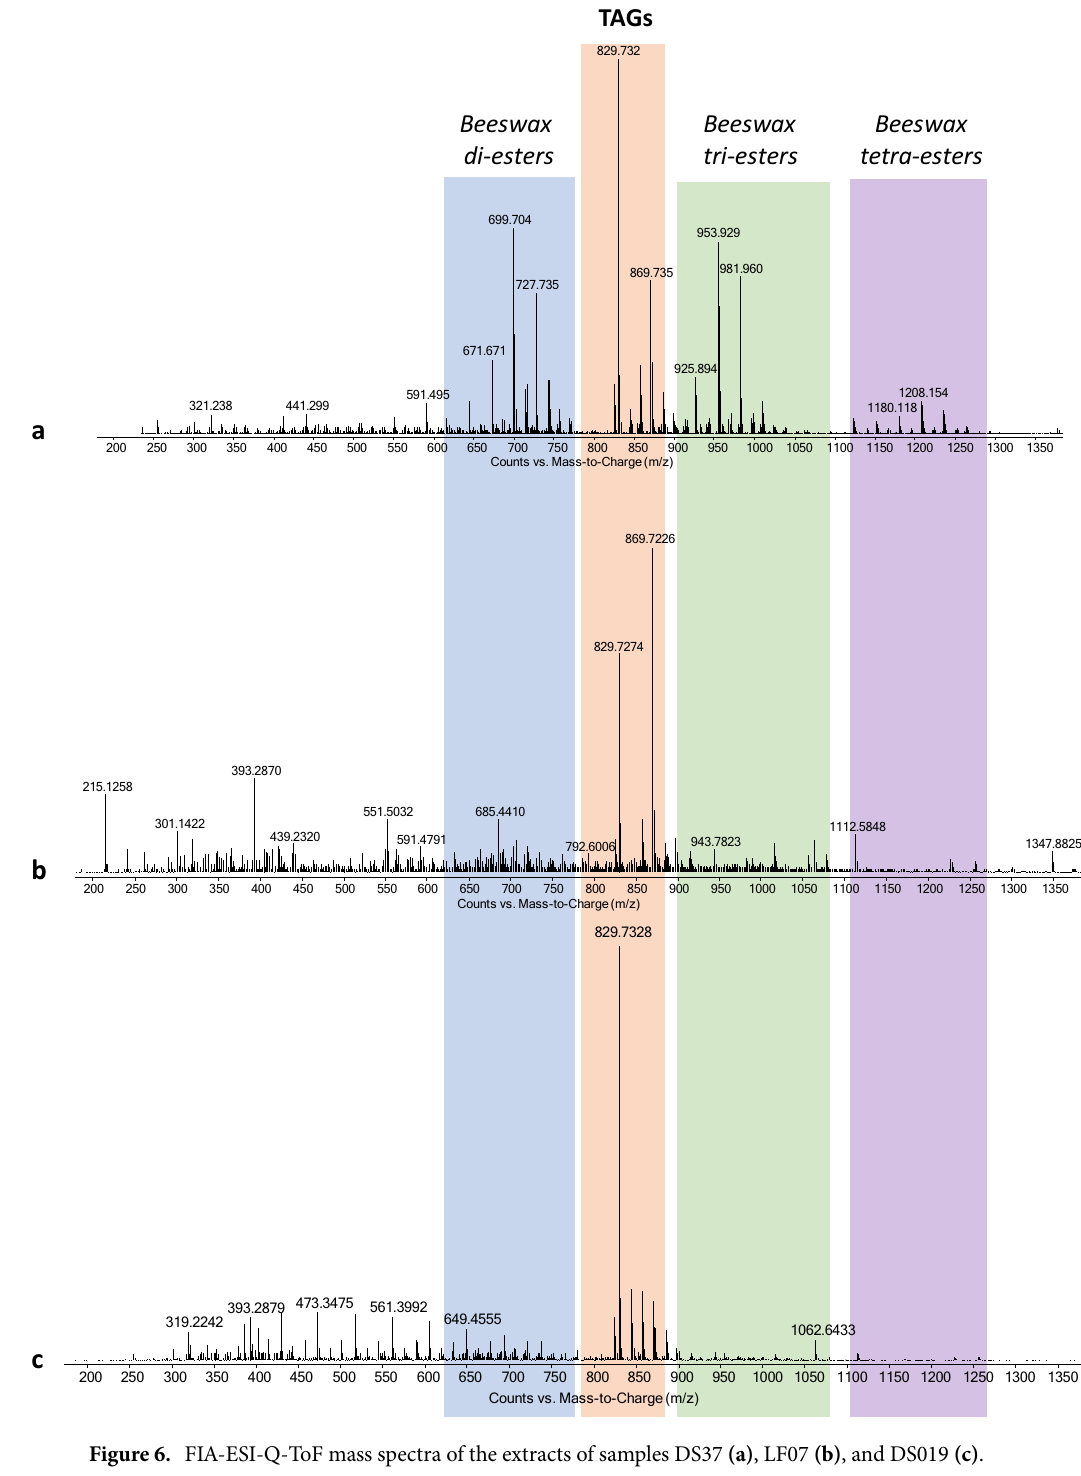
Figure 6. FIA-ESI-Q-ToF mass spectra of the extracts of samples DS37 (a) , LF07 (b) , and DS019 (c)